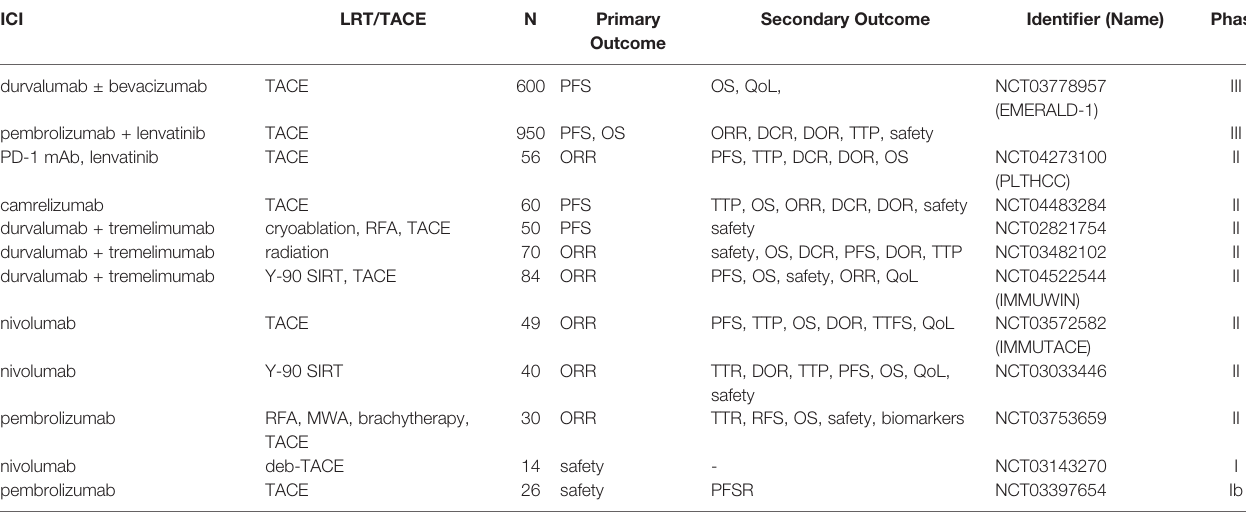
TABLE 1 | Ongoing clinical trials of immune checkpoint inhibitors (ICI) in combination with locoregional therapies (LRT) or transarterial chemoembolization (TACE). ICI